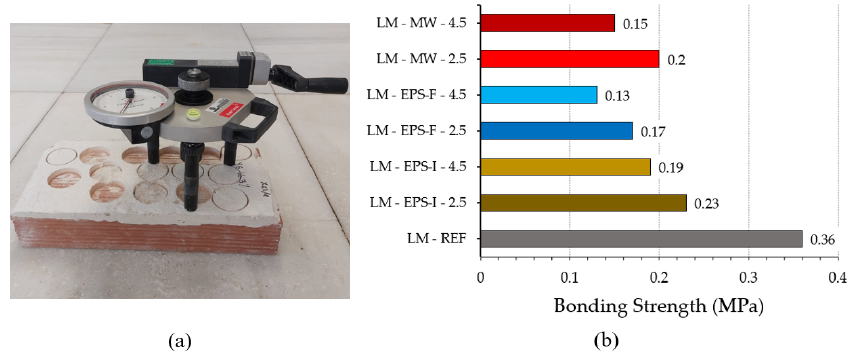
Figure 6. Bonding strength test. ( a ) Adhesion measuring equipment and tested sample; ( b ) results obtained for the different batches.